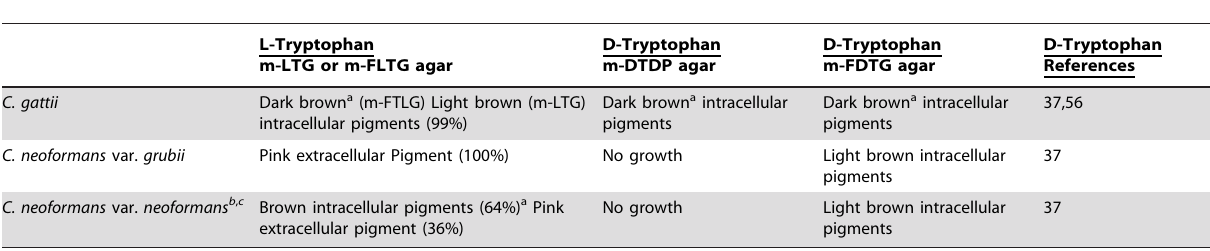
Table 2. Comparison of pigment production from L- and D-Tryptophan by Cryptococcus spp.